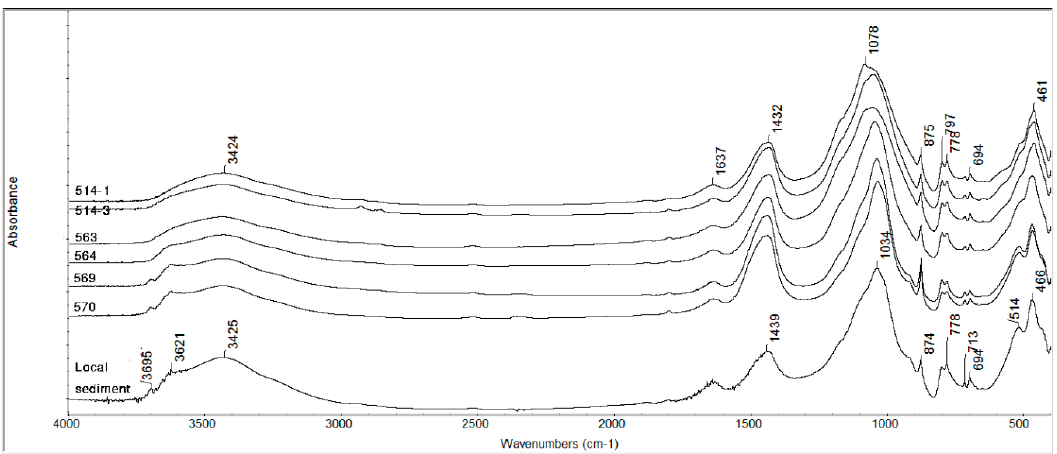
Figure 4. Infrared spectra of the 6 < 500 µ m samples from the upper pottery chamber (514-1 and 514-3) and the sherd layer in the lower firing chamber (from north to south: 563, 564, 569, and 570